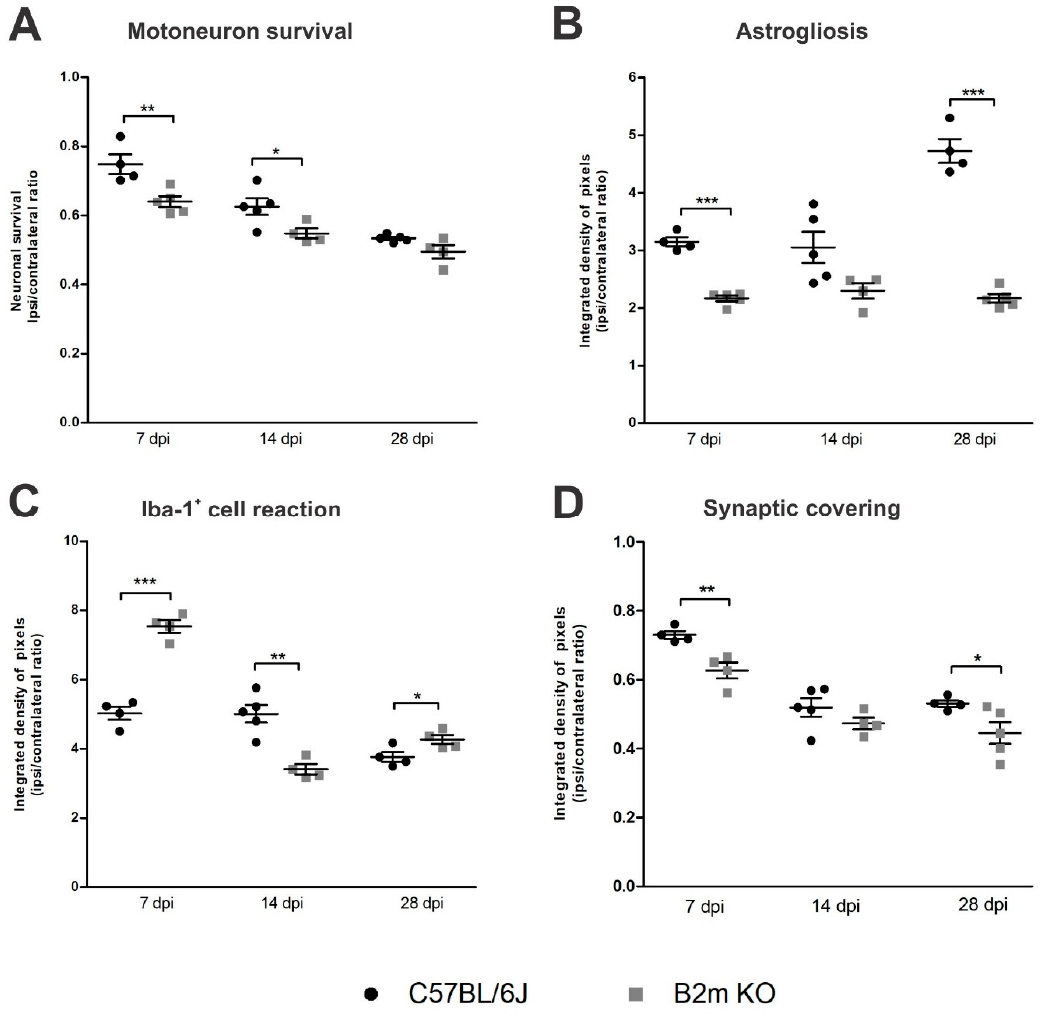
Figure 10. Comparative time course analysis of motoneuron-like cell survival ( A ), astrogliosis ( B ), Iba-1 + cell reaction ( C ) and synaptic covering ( D ) in WT and β 2m KO mice. Note that the progressive loss of motoneuron-like cells is equivalent in both strains, despite astrogliosis in β 2m KO that did not show increasing over time. On the other hand, the Iba-1 + cells reaction was more intense in β 2m KO mice in the acute phase after VRC, which was coincident to a more pronounced synaptic detachment in the same strain, a di ff erence that was detected also 28 dpi. Graphs show the comparative quantification among time points (ipsi / contralateral ratios); Significance levels: * p < 0.5, ** p < 0.01, *** p < 0.001.